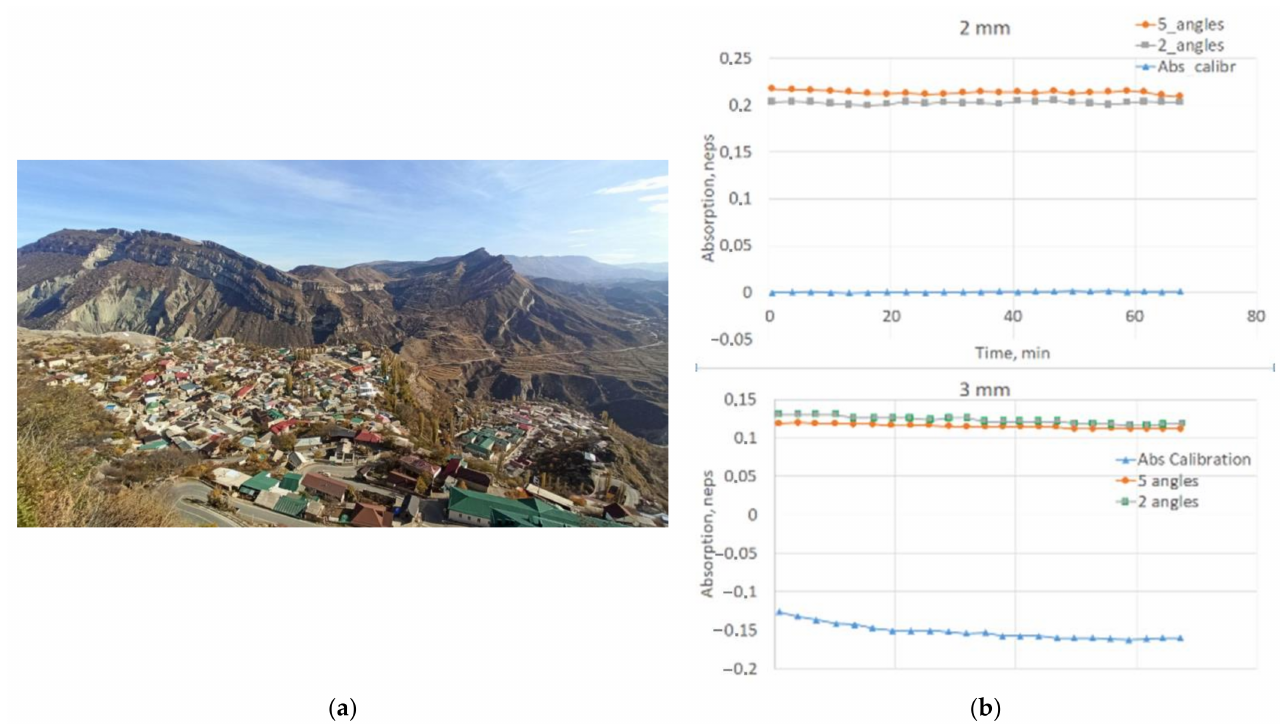
Figure 8. ( a ) Dagestan, Gunib, Mount Mayak, 2400 m, 350 clear days per year. ( b ) Measurements at λ 3 mm and τ = 0.12 Np and at λ 2 mm and τ = 0.2 Np, 2 November